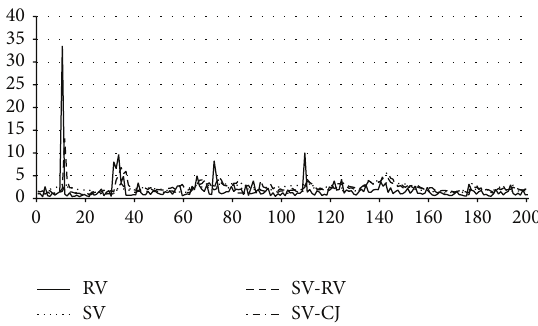
Figure 2: Comparison of the out-of-sample forecasting perfor- mance of the SV, SV-RV, and SV-CJ model. In the figure, RV represents the true volatility; SV, SV-RV, and SV-CJ represent the forecast volatility of the SV, SV-RV, and SV-CJ model,